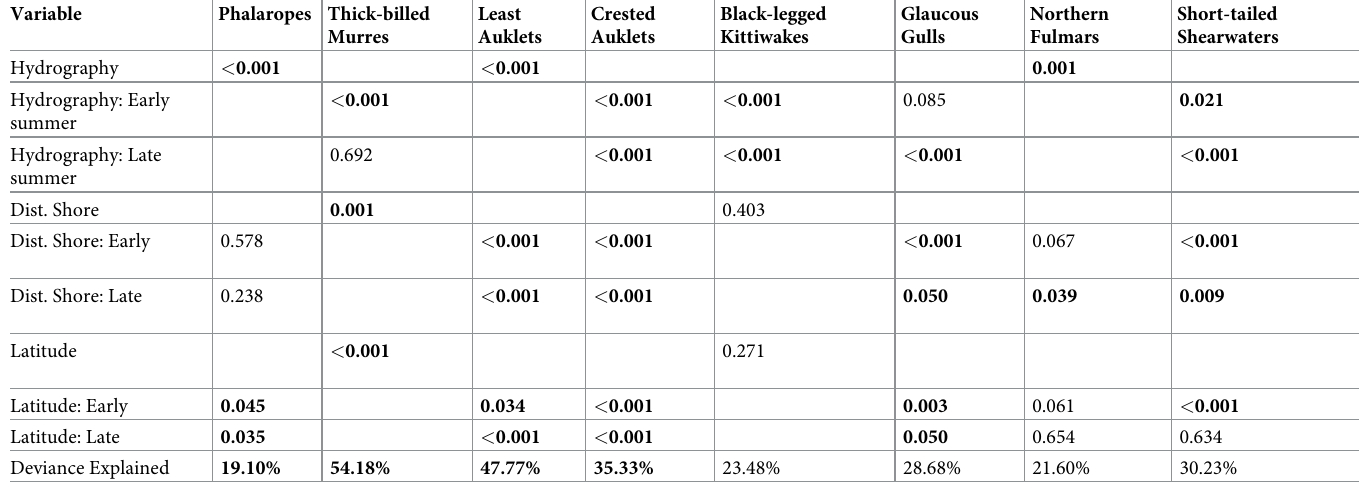
Table 6. Variables that best described the variation in distribution and abundance of 8 species of seabirds in the northeastern Chukchi Sea, 2008–2018. P-values indicate statistical significance from generalized additive models (GAM). Dist. Shore is the distance to shore from the centroid of each cell in the sampling grid.